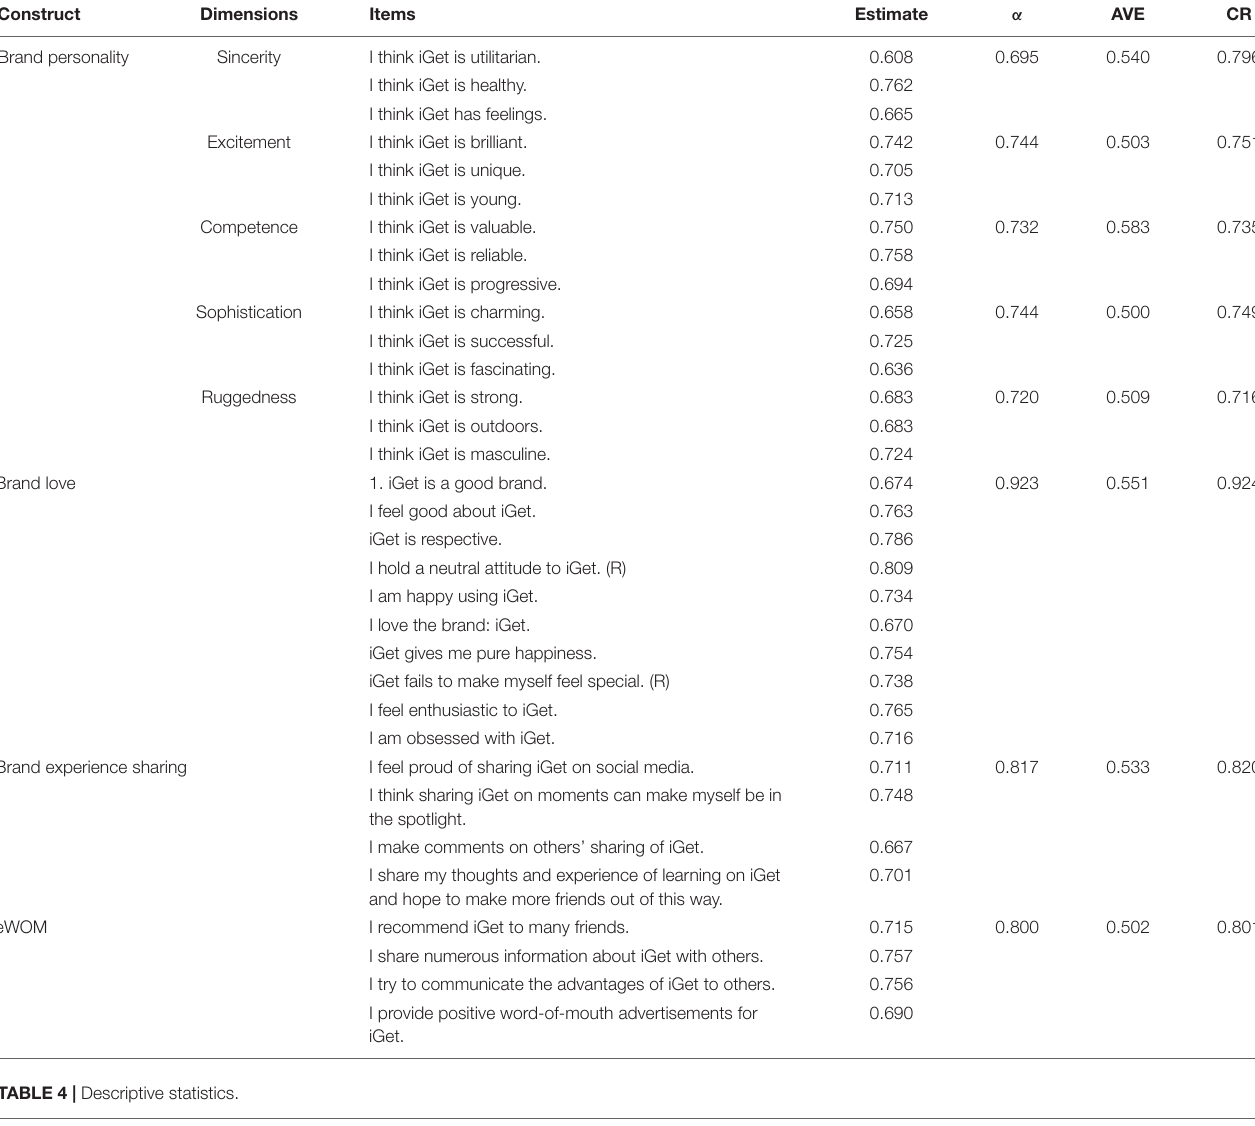
TABLE 3 | Reliability and validity analysis.